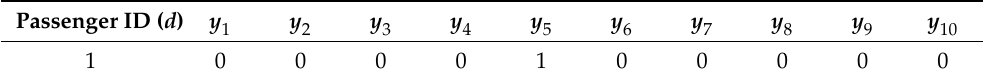
Table 16. Solution y for Passengers.